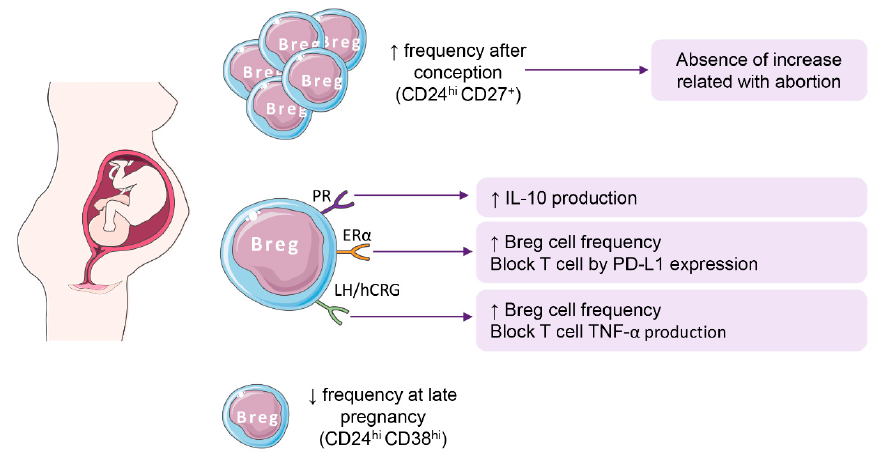
chorionic gonadotropin